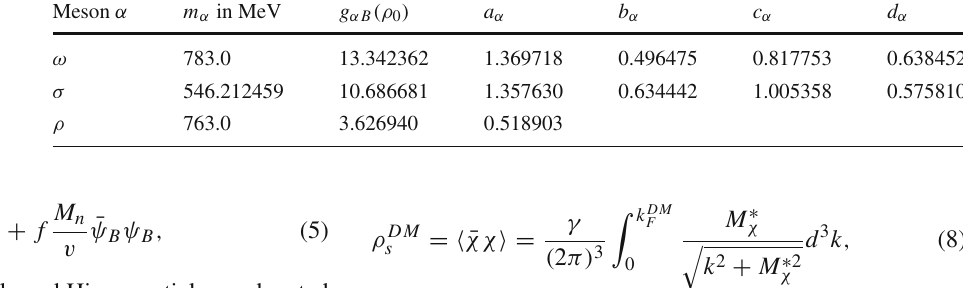
Table 1 Meson masses